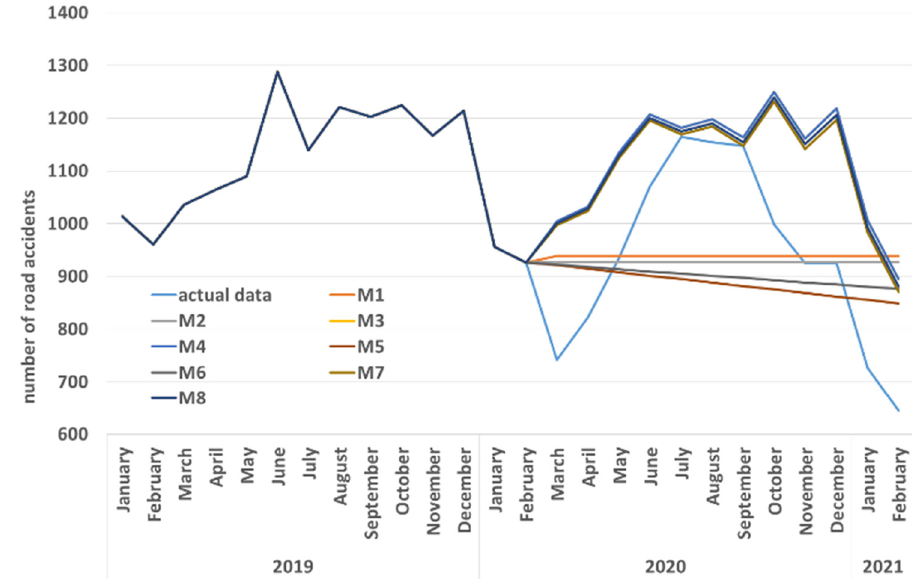
Figure 11: Comparison of the number of road accidents in